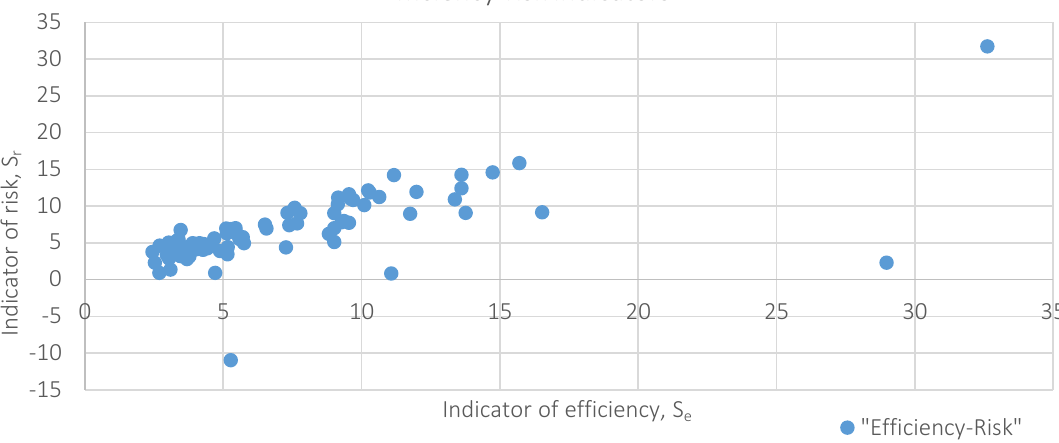
Figure 2. Banking system of Ukraine in the “Efficiency-Risk”